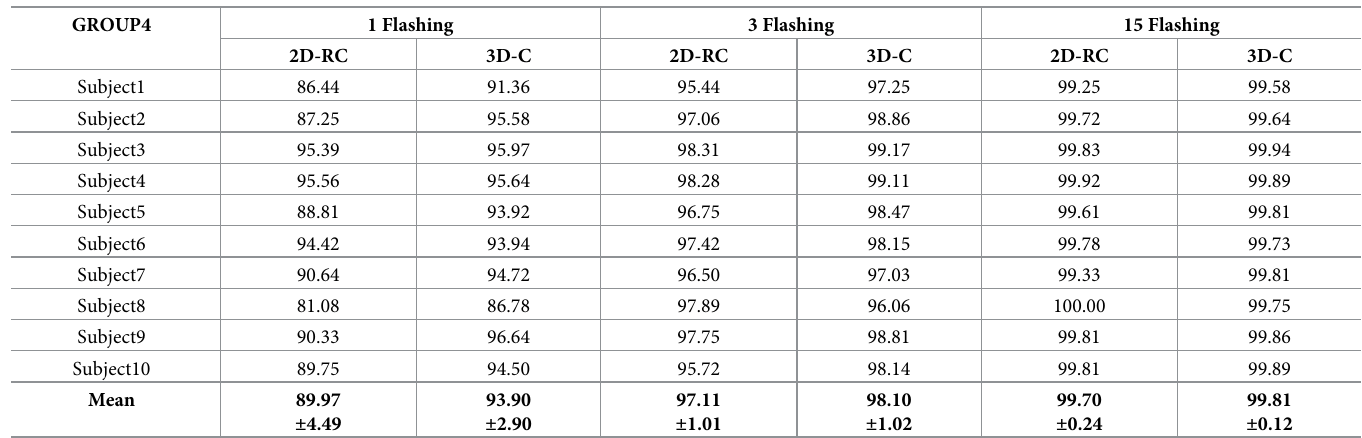
Table 3. Group 4 electrodes accuracy rates.